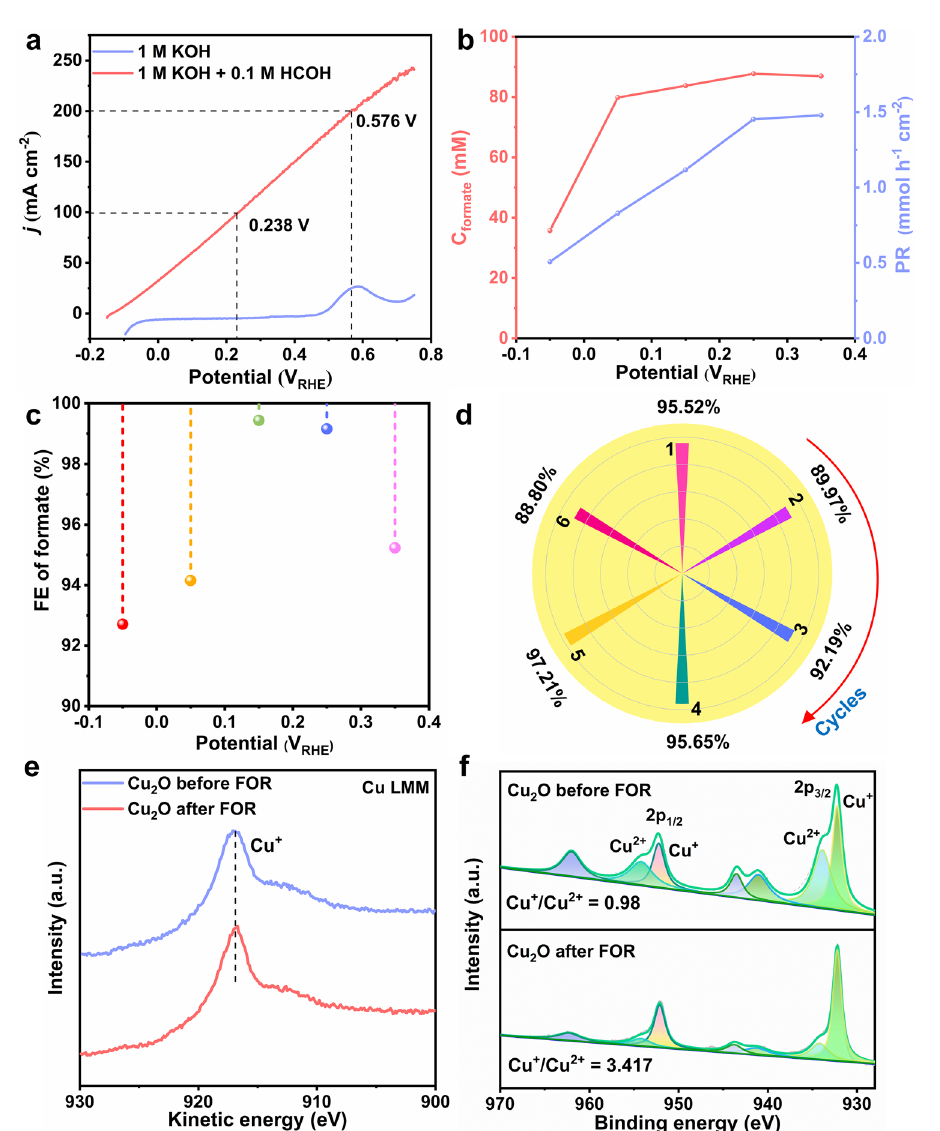
Fig. 4 Electrochemical performance and structural characterization of Cu 2 O for anodic FOR. a LSV curves of Cu 2 O in 1 M KOH electrolyte with or without formaldehyde. b F ormate concentration formed by formaldehyde electrooxidation and total formate production rate (PR), c FE of formate for complete conversion of formaldehyde at different potentials. d FE of formate using Cu 2 O for six successive electrolysis cycles. e Auger Cu LMM, f Cu 2 p spectrum of Cu 2 O before and after